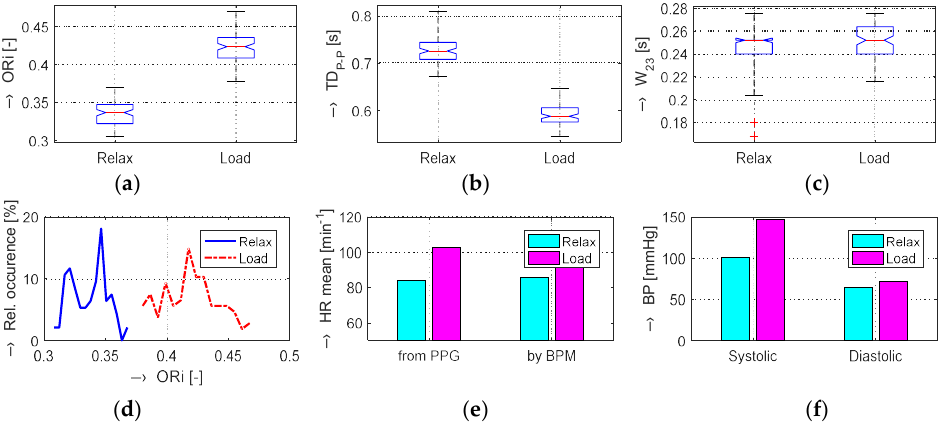
Figure 7. Changes in evaluated human cardiovascular parameters determined in relaxation and sporting stimulation phases with both BP and HR values significantly increased: box-plot of basic statistical parameters of ( a ) ORi, ( b ) TD P-P , and ( c ) W 23 values; ( d ) comparison of histograms of ORi values; ( e ) bar-graphs of HR determined from the PPG signal and measured by the BPM device; ( f ) comparison of systolic and diastolic blood pressure values; male